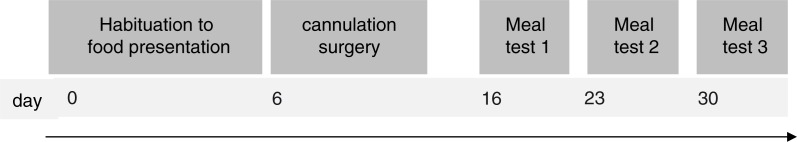
Time line of meal presentation and blood sampling. During meal-test sessions, test foods were consumed within 15 min by all rats. Blood samples were collected 10 min before food presentation and at multiple post-meal time points.